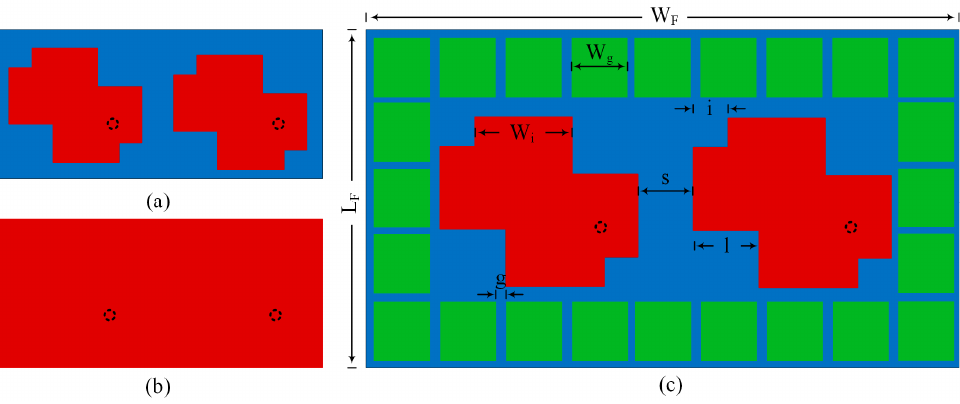
Figure 2. MIMO antenna without parasitic elements: ( a ) top-view; ( b ) bottom-view; ( c ) MIMO antenna with parasitic elements.